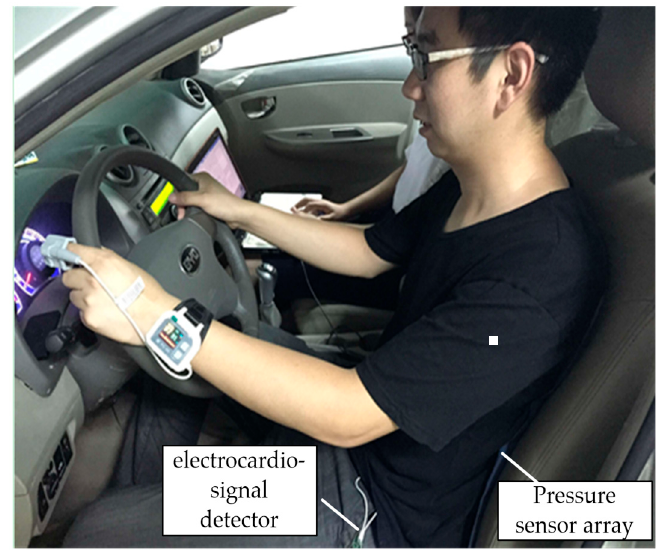
Figure 4. SCANeR simulation training system.